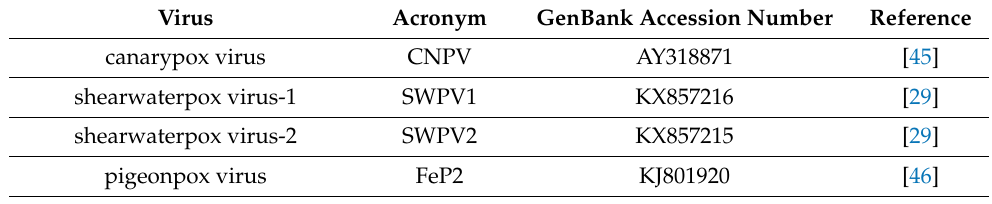
Table 1. Related poxvirus genome sequences used in further analysis for